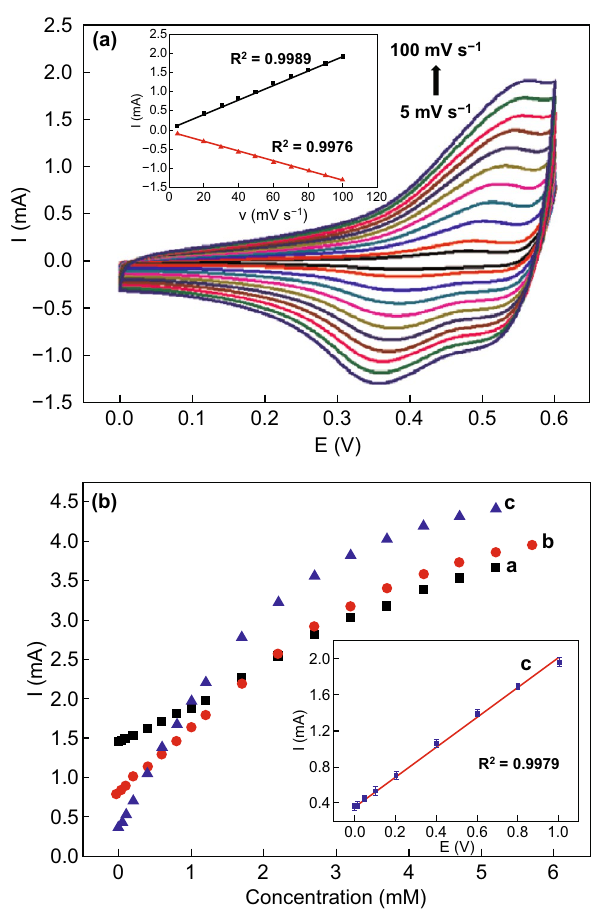
Fig. 25 a CV curves of NiCo 2 O 4 hollow nanorods with various scan rates. Inset: redox peak currents as a function of the scan rates, b variation in response current for NiO (curve a), Co 3 O 4 (curve b), and NiCo 2 O 4 hollow nanorods (curve c) as a function of glucose concen- trations. Inset: calibration curve of NiCo 2 O 4 hollow nanorods. Repro- duced with permission from Ref. [142]. Copyright © 2015 Elsevier